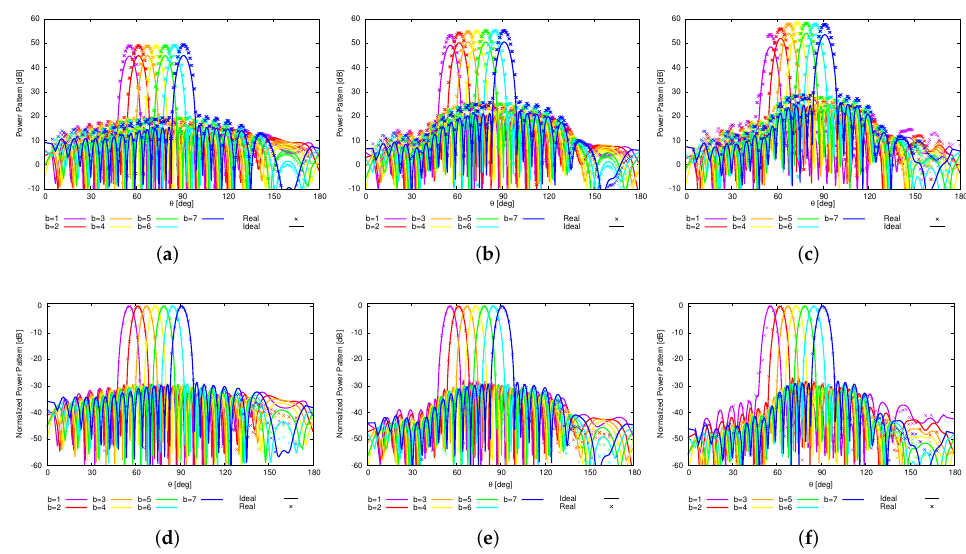
Figure 15. Numerical Assessment (Sparse CPA, M = 16, d = λ along the φ = 0.0 ◦ cut of the ( a – c ) actual and ( d – f ) normalized power patterns radiated by the CPA configurations with vertical sector width equal to ( a , d ) ψ = 30 ◦ , ( b , e ) ψ = 60 ◦ , and ( c , f ) ψ = 90 ◦